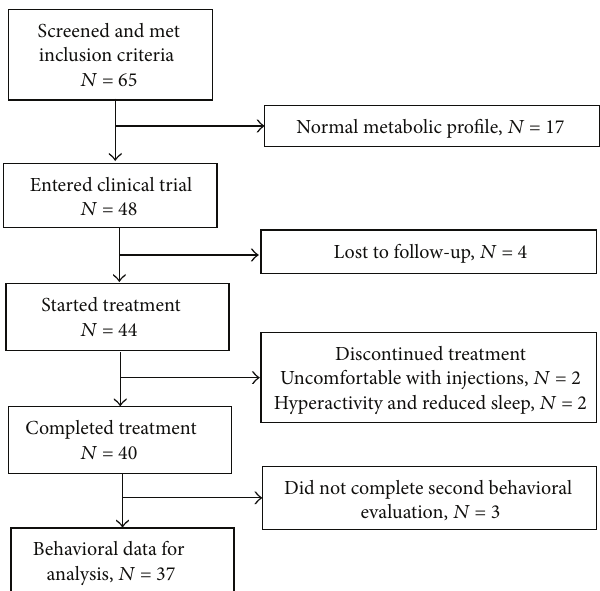
Figure 1: Flowchart of patients who met inclusion criteria for the